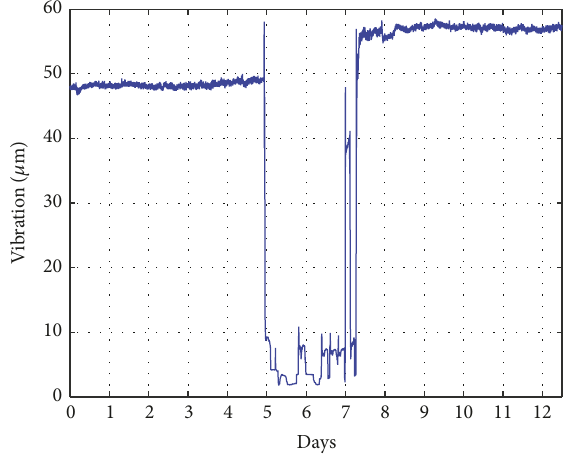
Figure 7: [CS1] Test data for novelty detection (in month 4).